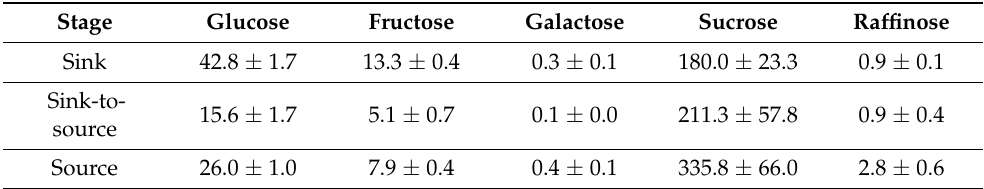
Table 3. Concentrations of selected soluble carbohydrates at the sink-to-source, source, and sink stages in the blades (mean ±